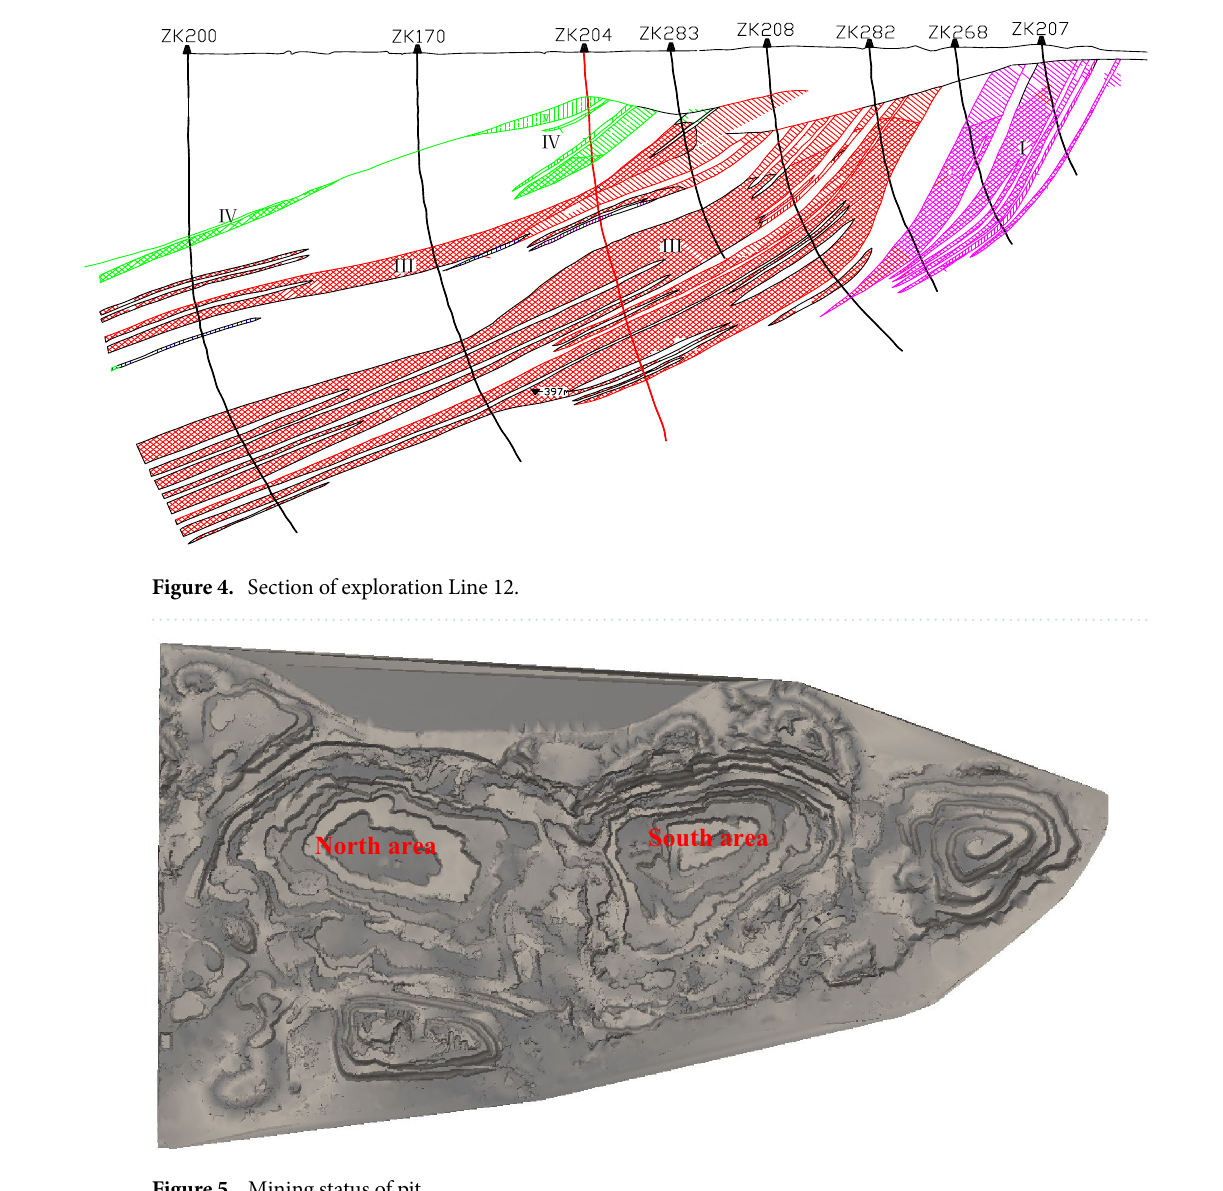
Figure 5. Mining status of